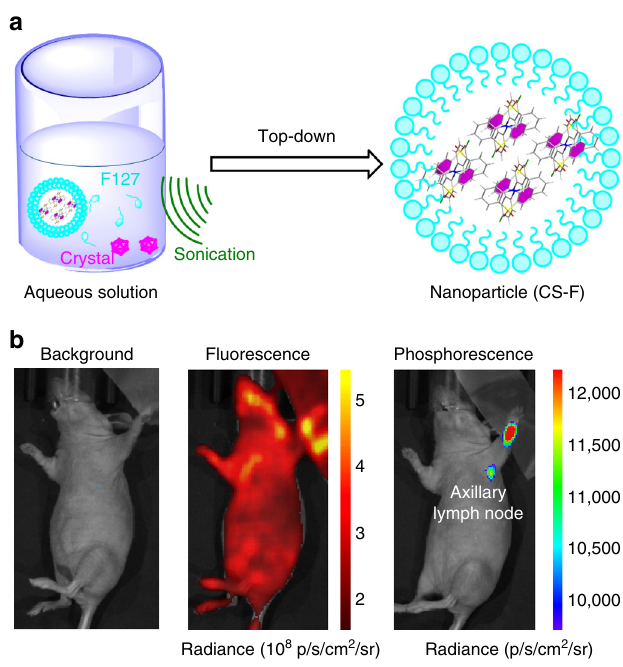
Fig. 6 In vivo real-time excitation-free phosphorescent imaging of lymph nodes. a Top-down approach to synthesize the water-soluble nanoparticles of CS-F: the crystal was added to the aqueous solution of PEG-b-PPG-b- PEG (F127) under continuous sonication, then the aqueous solution was fi ltered through a 0.22 µ m polyvinylidene fl uoride (PVDF) (Millipore). b Ultralong phosphorescence and fl uorescence imaging of lymph node in living mice 1 h after the intradermal injection of CS-F nanoparticles into the forepaw of